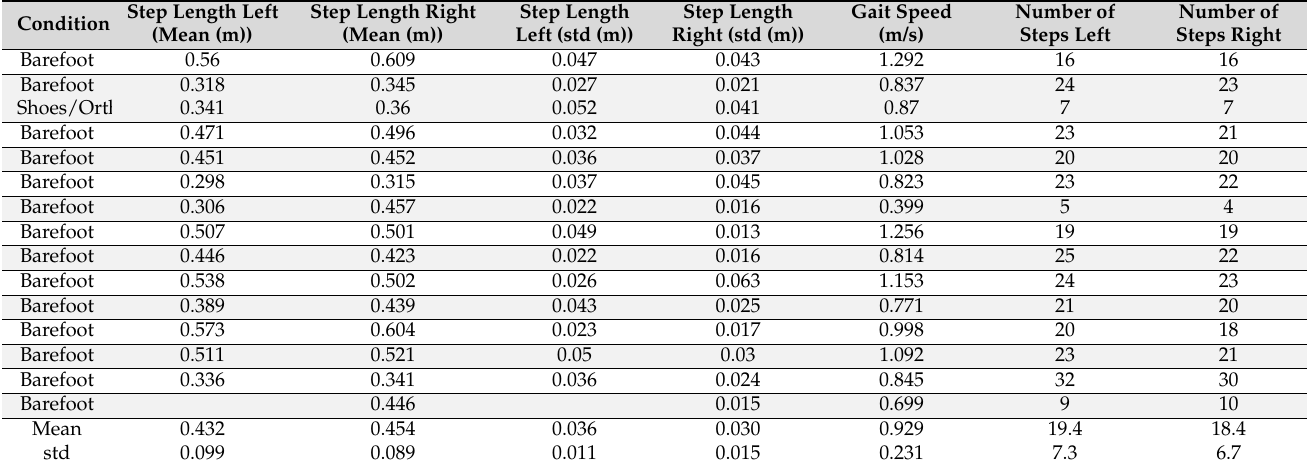
Table 2. Mean and standard deviation (std) of gait parameters in the test dataset.